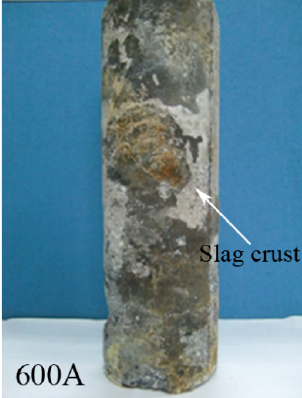
Figure 6: Appearance of 5 wt.% TiB 2 /Al ingots prepared at 600A. Table 2: Melting times and slag pool temperatures in preparation of composite at different melting currents.